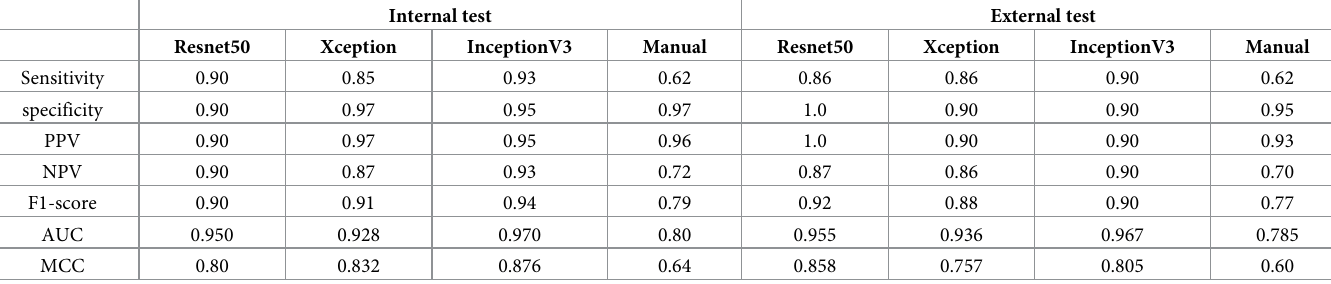
Table 1. Comparison of performances of deep learning and manual in internal and external test.